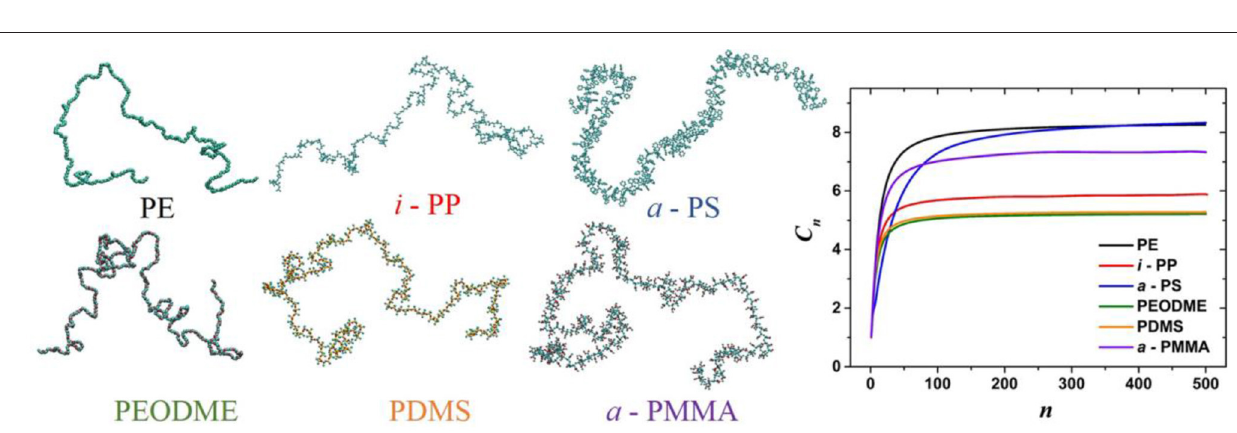
FIGURE 11 | Characteristic snapshots from the single chain Monte Carlo simulations of Tzounis et al. [88] for six different polymers [polyethylene (PE), isotactic polypropylene (i-PP), atactic polystyrene (a-PS), poly(ethylene oxide) dimethyl ether (PEODME), poly(dimethylsiloxane) (PDMS), and atactic poly(methyl methacrylate) (a-PMMA)], and the simulation predictions for the dependence of chain characteristic ratio C n on the number of backbone bonds n at 450K. Reprinted (adapted) with permission from Tzounis et al. [88]. Copyright (2017) American Chemical